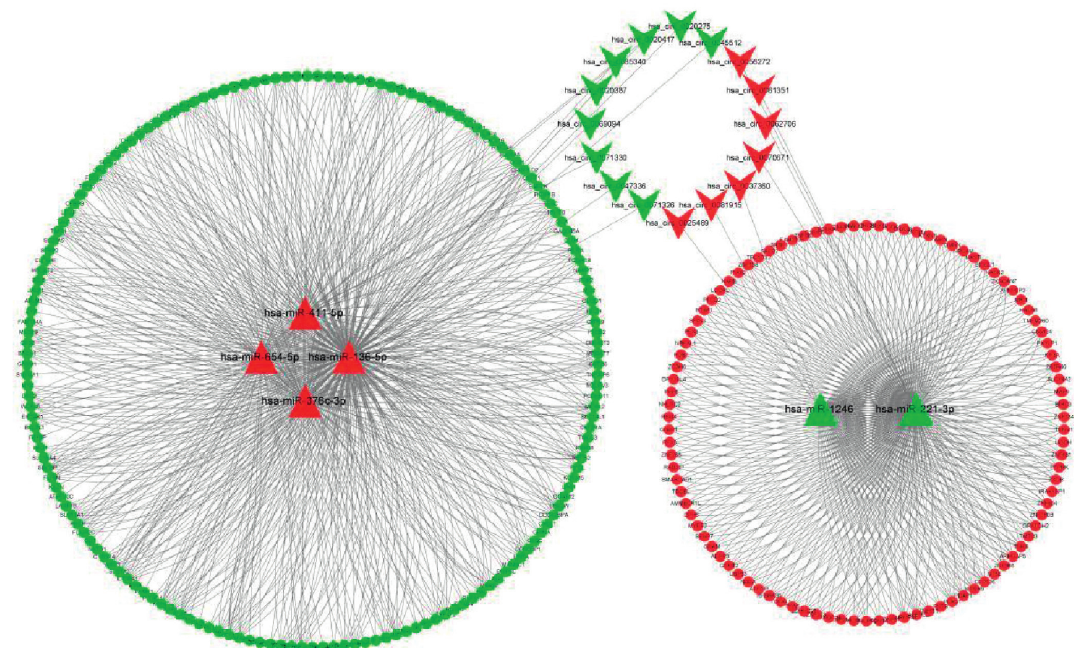
Figure 3: The circRNA-miRNA-mRNA regulatory network in coronary artery disease. The shape of V represents circRNAs, triangle represents miRNA, and ellipse represents mRNA. The red and green indicate upregulated expression and downregulated expression, respectively. The lines represent the connection between each other. circRNAs, circular RNAs; miRNAs, micro-RNAs.